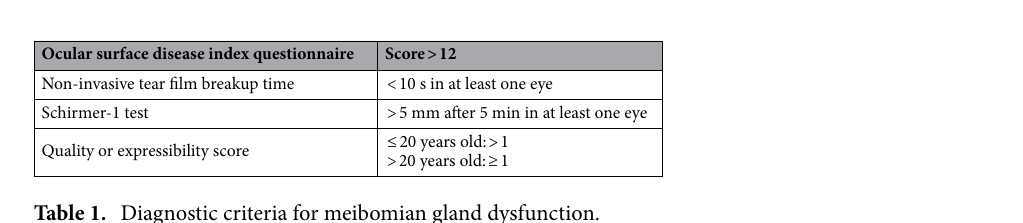
Table 1. Diagnostic criteria for meibomian gland